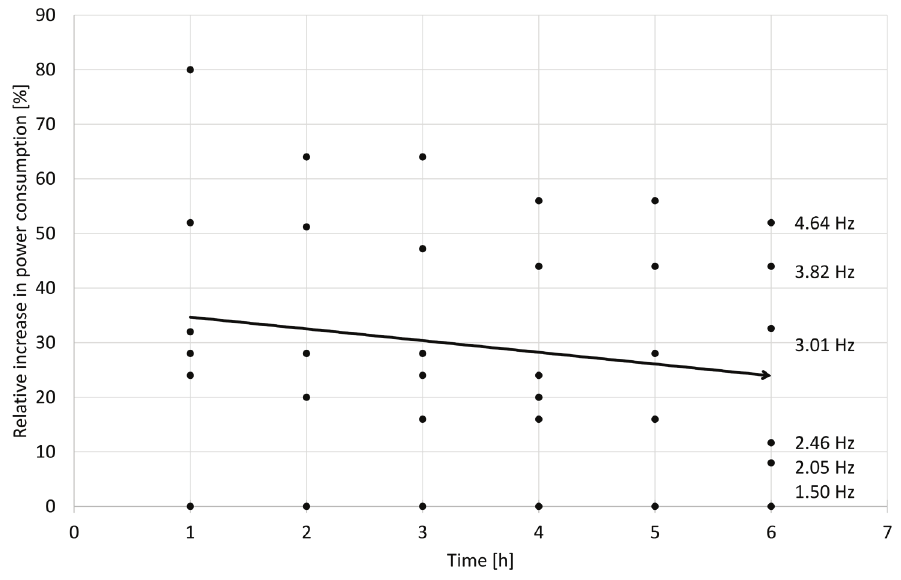
Fig. 5 – Decrease in relative power consumption over time at different frequencies (12 % SL, α-cellulose, 3 mm baffle, 10 mm